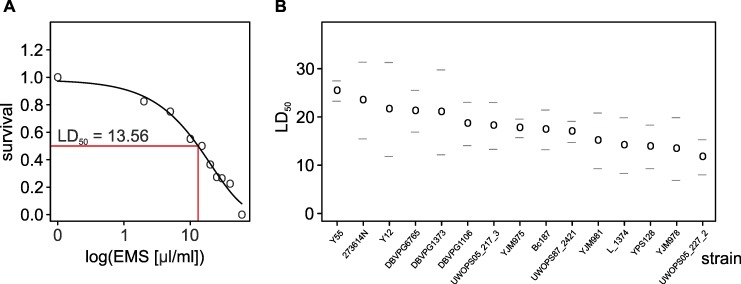
Survival immediately after EMS treatment.(A) Example of a single strain’s survival curve. A Weibull curve is fitted to estimate the LD50 (lethal dose killing 50% of population). Each point is the mean of two replicates. (B) LD50 values with 95% confidence limits of individual strains ranked according to EMS sensitivity (low sensitivity requires a high dose of EMS for LD50).